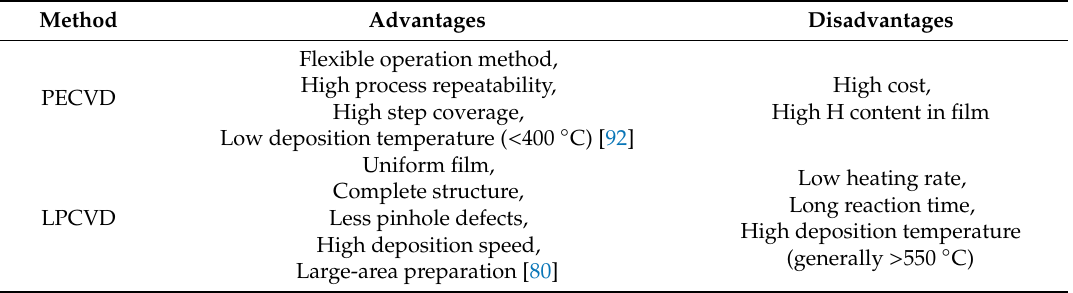
Table 2. Advantages and disadvantages of SiN x O y film prepared by PECVD, LPCVD, HTCVD and Photo-CVD